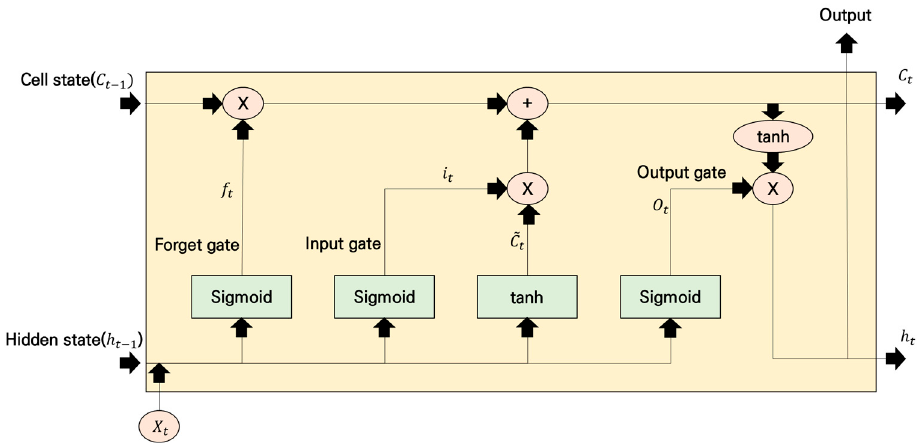
Figure 5. Conceptual diagram of the LSTM.